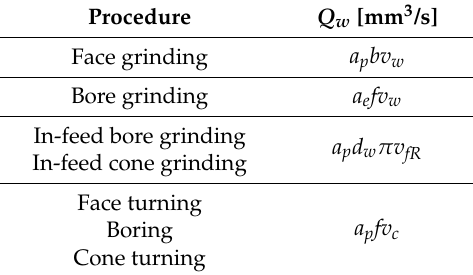
Table 2. Calculation of the theoretical parameter of the material removal rate in different